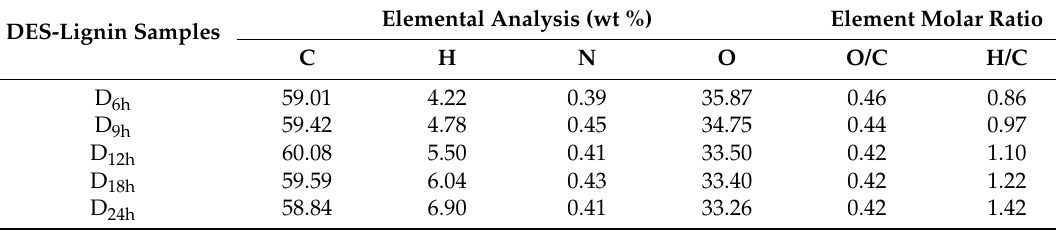
Table 2. Elemental analysis of DES-lignin samples (D 6h , D 9h , D 12h , D 18h , D 24h ). Elemental Analysis (wt DES-Lignin Samples